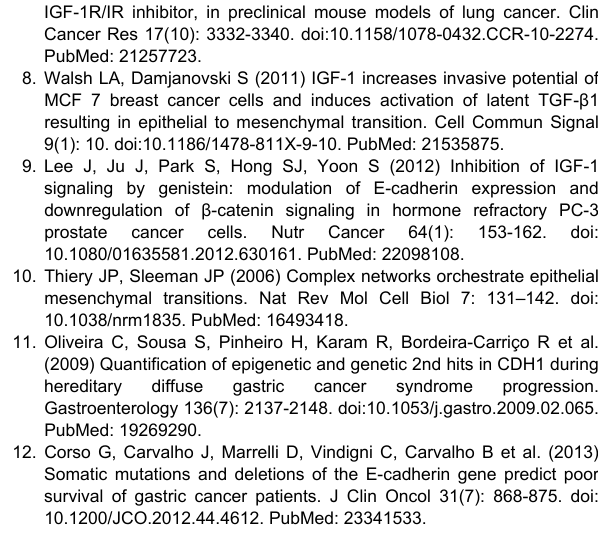
Figure S1. Effects of exogenous E-cadherin expression on the phosphoproteome profile. Total cell lysates from MDA- MB-435+mock and MDA-MB-435+E-cad were obtained and analyzed by Phospho-RTK array using 300 µg of proteins. The phosphor-RTK coordinates are shown on the top of figure illustrating the localization of the spots containing immobilized antibodies on the nitrocellulose membrane. The bar graphs show the relative densities of black dots. The most pronounced changes are observed in IR (coordinates B17 and B18) and IGF-IR (coordinates B19 and B20). Figure S2. Effects of stimulation of Mock-transfected cells with insulin and IGF-I on the phosphorylation of tyrosine kinase receptors and downstream proteins. (A,B) Total cell lysates from MDA-MB-435+mock cells and MDA- MB-435+mock stimulated (24h) with insulin or IGF-1 were obtained and analyzed by Western-blot for phospho- IR(Tyr1150-51)/phospho-IGF-IR(Tyr1135-36), IR, IGFR, Akt, phospho-Akt (Ser 473), ERK 1/2, phospho-ERK 1/2, β-catenin and E-cadherin. Increased phosphorylation levels of IR, IGF- IR, ERK 1/2 and Akt were observed after stimulation with insulin or IGF-I. Tubulin was used as a loading control.